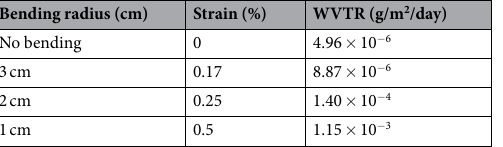
Table 2. Results of the calcium corrosion tests after cyclic bending: water vapor transmission rates according to the bending radius and strain.